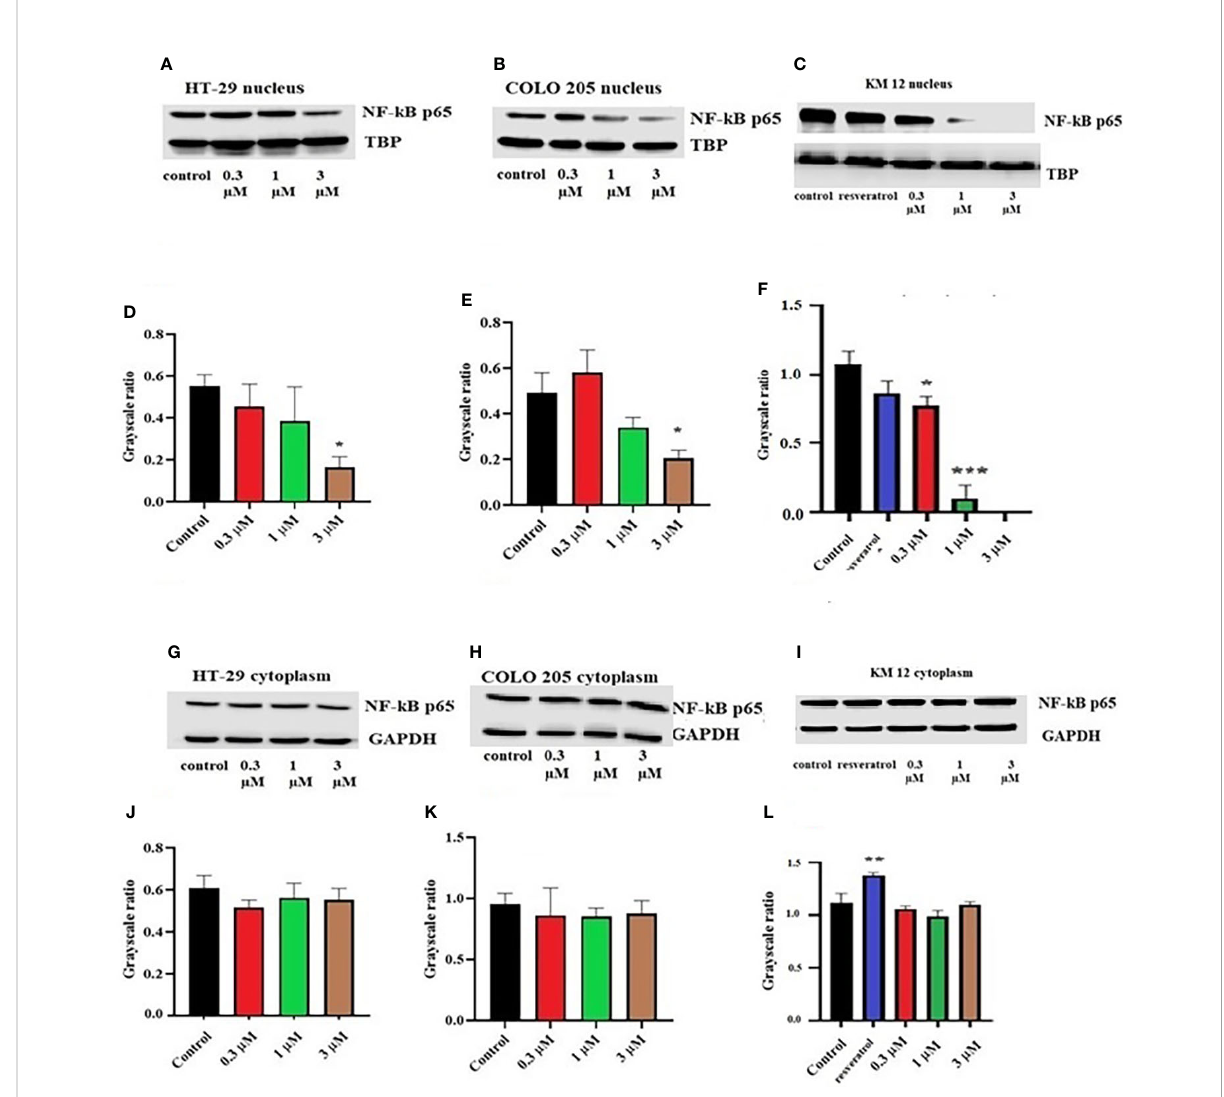
FIGURE 2 Effect of ITH-6 on the expression of the nuclear fraction of NF-kB p65 protein on (A) HT-29, (B) COLO 205, and (C) KM 12 cells and the cytoplasmic fraction on (G) HT-29, (H) COLO 205, and (I) KM 12 cells. The effect of ITH-6 on the expression of the nuclear and cytoplasmic fraction of NF-kB p65 protein was tested after the cells were treated with 0.3, 1, and 3 mM of ITH-6 for 72 hours. Relative quanti fi cation of the effect of ITH-6 on (D – F) the nuclear and (J – L) cytoplasmic fraction of NF-kB p65 in HT-29, COLO 205, and KM 12 cells. The expression level of NF-kB p65 protein was normalized to TBP (nucleus) and GAPDH (cytoplasm). Equal amounts of total cell lysates were used for each sample, and a Western blot analysis was performed. The fi gures are representative of three independent experiments. * p <.05, ** p <.01 and *** p <.001 compared with the control